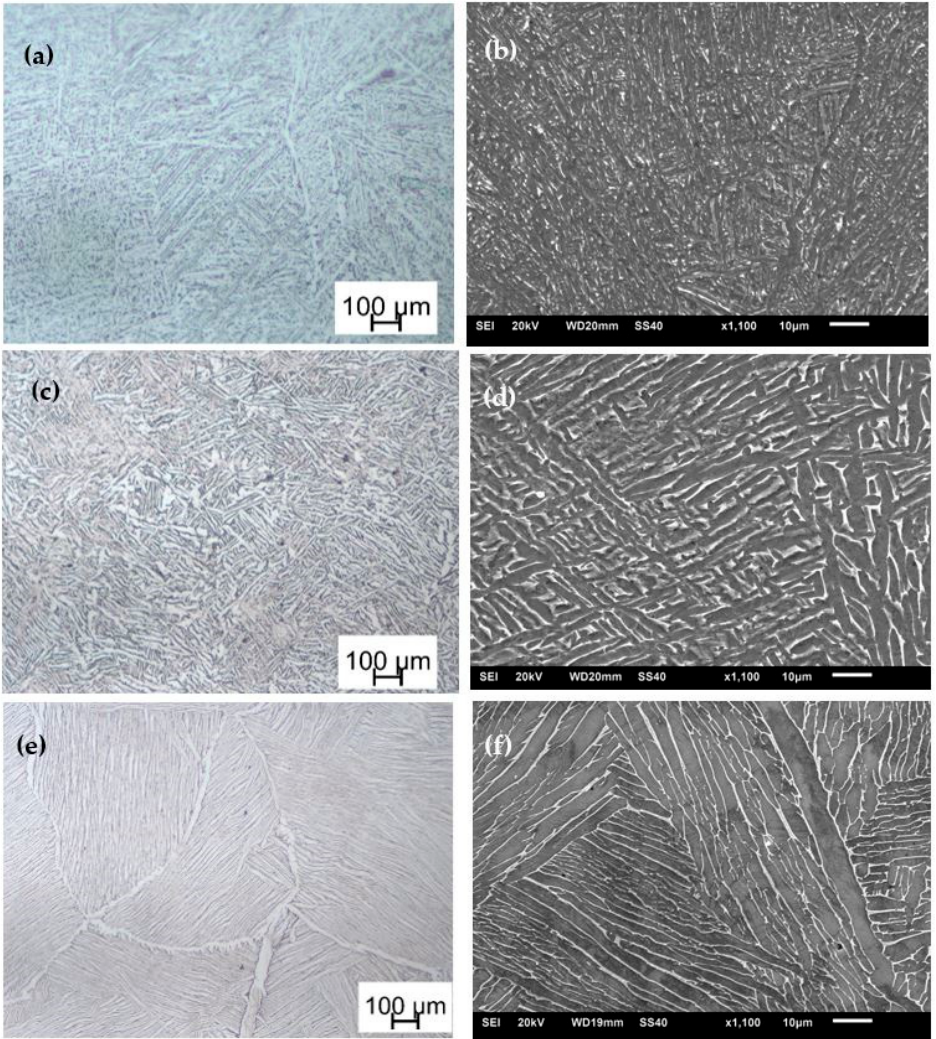
Figure 1. ( a , c , e ) Optical images and ( b , d , f ) secondary electron images of ( a , b ) samples C, ( c , d ) samples D, and ( e , f ) samples E, respectively.